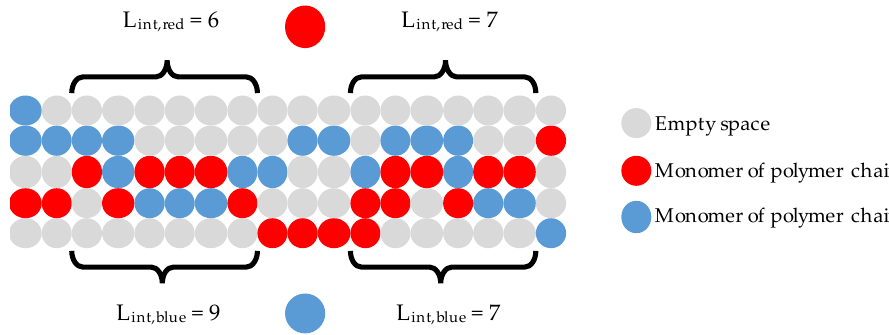
Figure 8. Two-dimensional illustration of the interaction length L int .